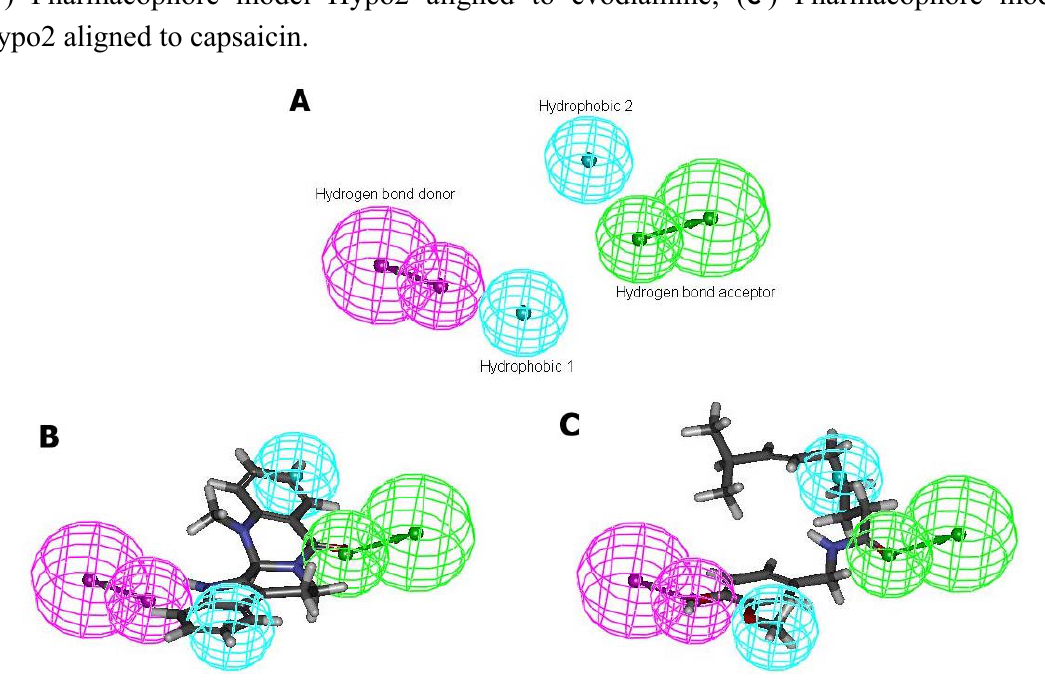
Figure 6. Docking conformation obtained for evodiamine (purple) was compared with that of the optimized one generated by Catalyst